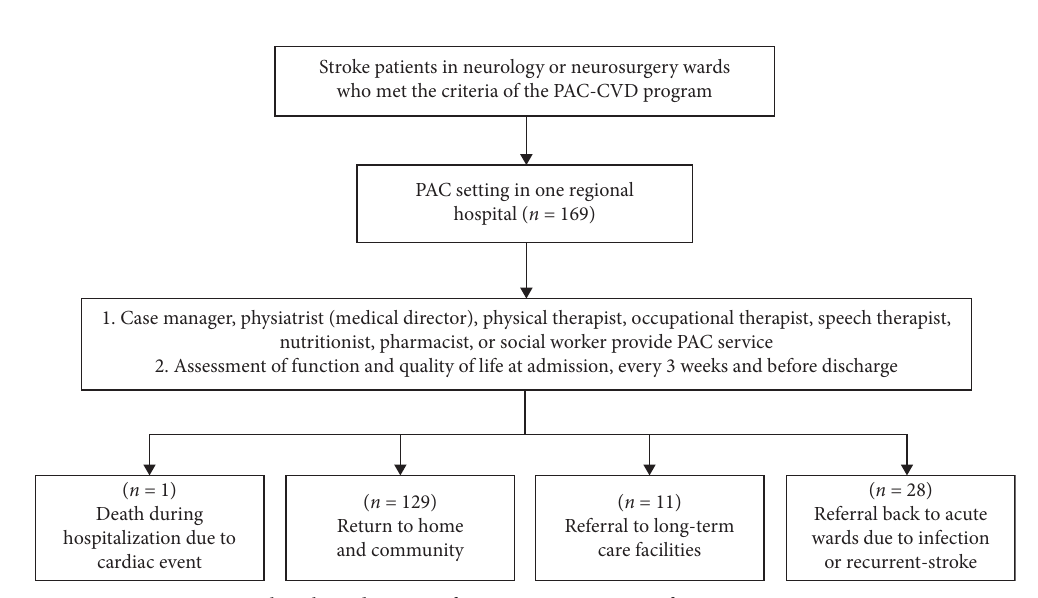
Figure 2: Flowchart diagram of management strategy for PAC-CVD